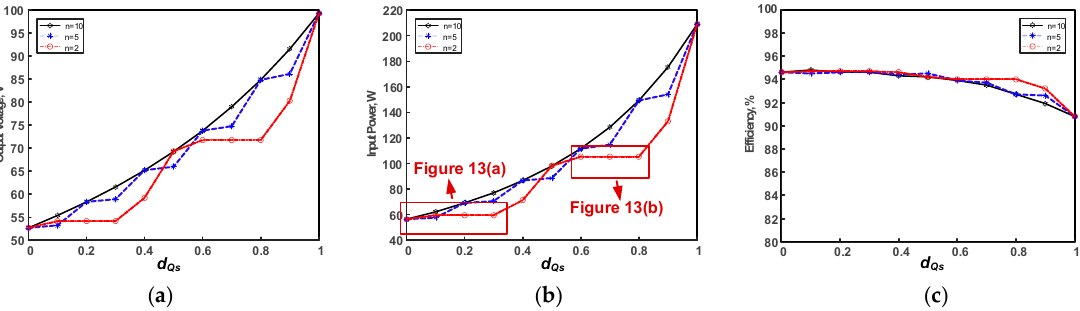
Figure 12. System performance under different frequencies and duty ratios ( a ) output voltage ( b ) input power ( c ) efficiency.